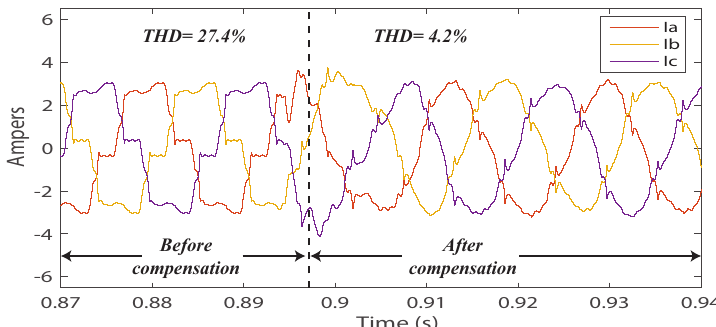
Figure 16. Three phase grid currents before and after